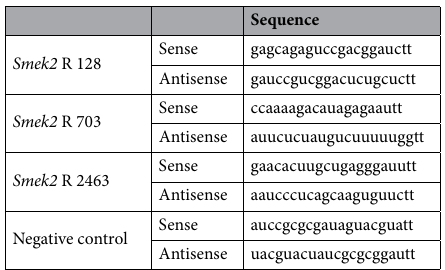
Table 5. Oligonucleotides for Smek2 siRNA. Mixture of Smek2 R 128, Smek2 R 703, and Smek2 R 2463 was used for Smek2 knockdown to enhance siSmek2 effectiveness.